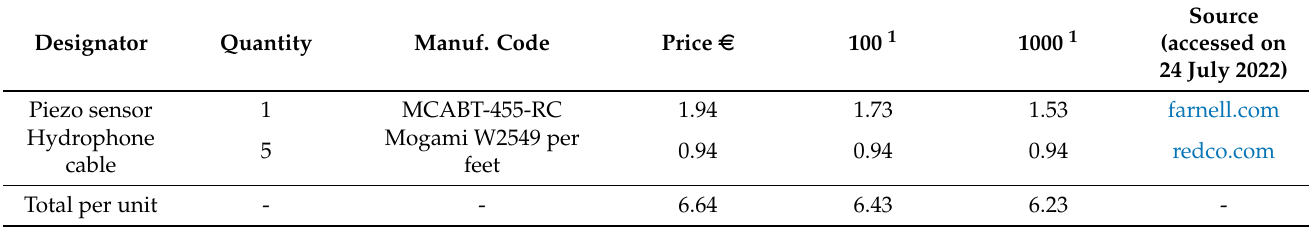
Table 4. Hydrophone sensor bill of